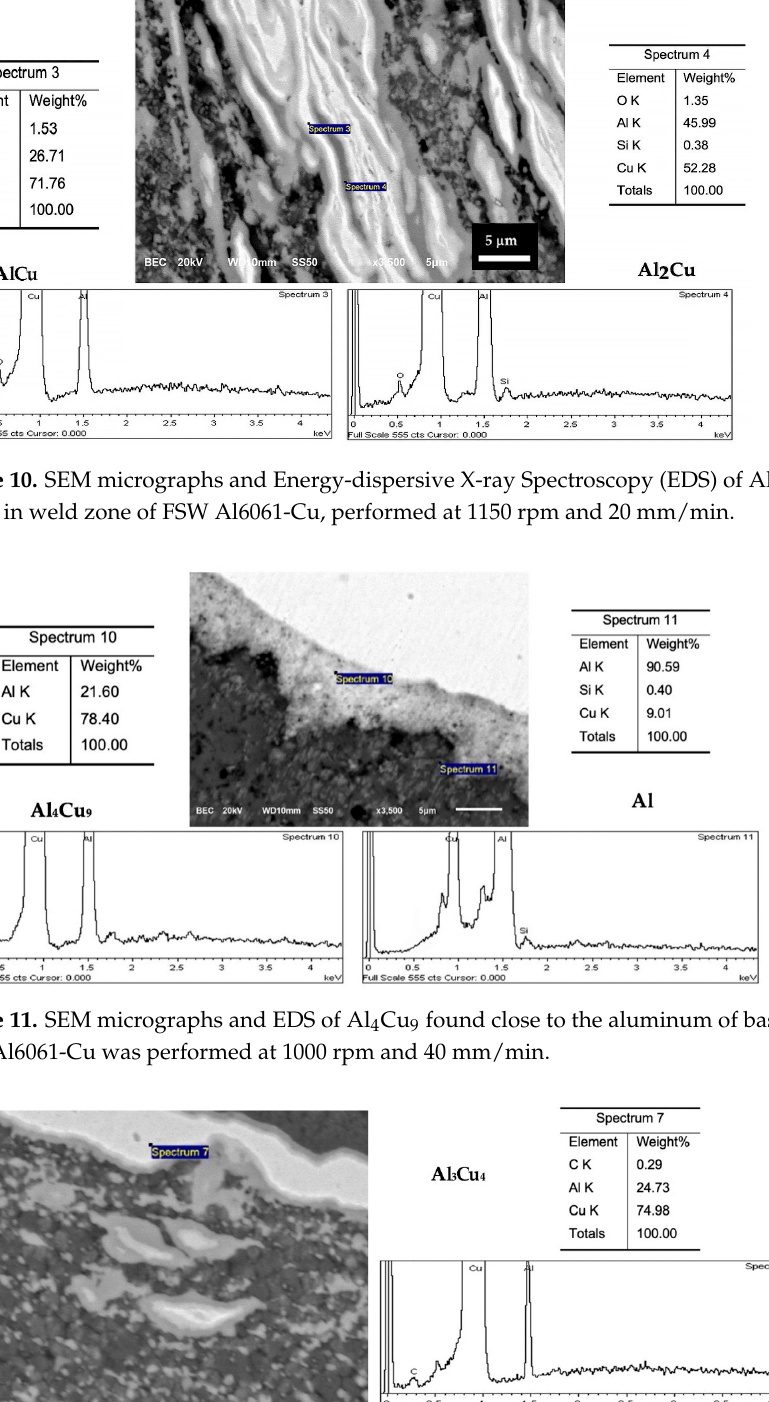
performed at 1000 rpm and 40 mm/min.